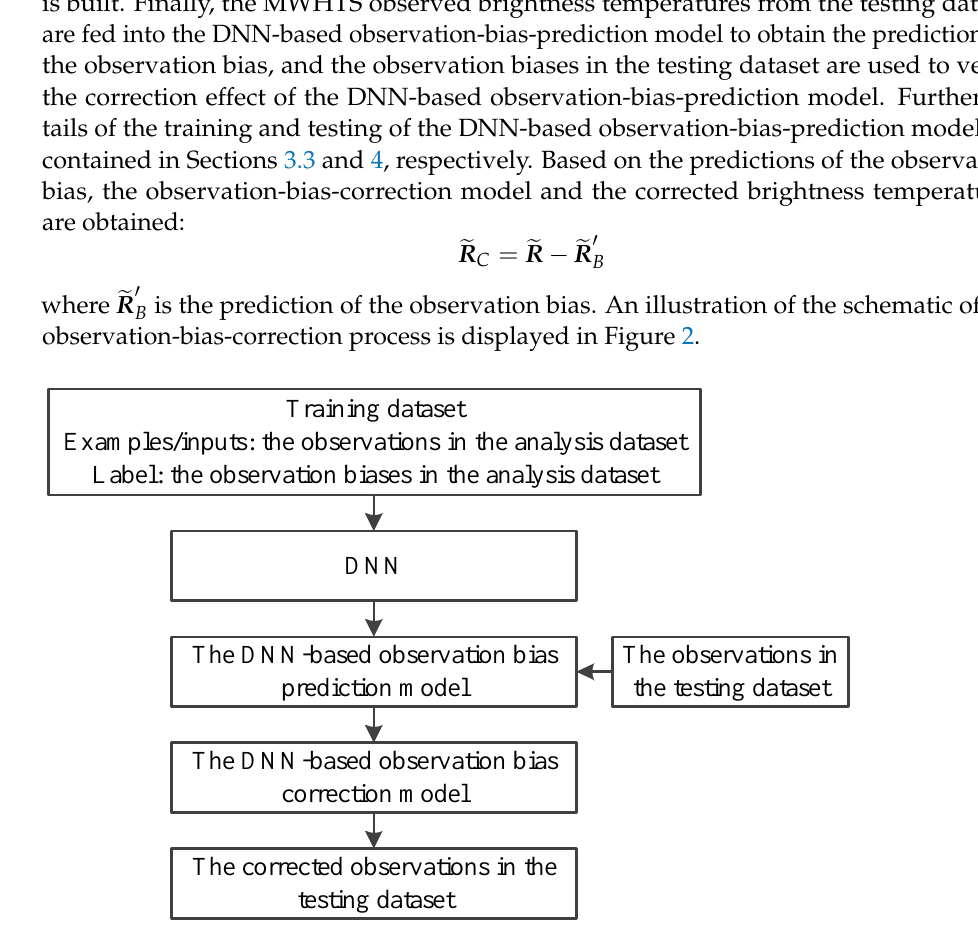
Figure 2. The schematic of the observation-bias